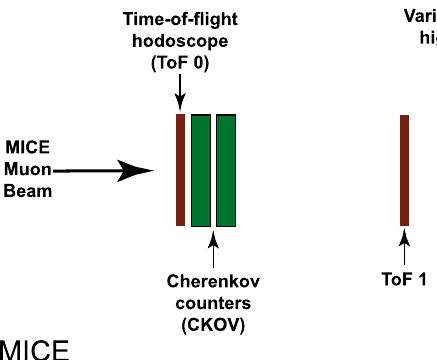
(TOF0, TOF1) [23,24], Cherenkov counters [25], scintillating-fibre trackers [26], KLOE-Light (KL) calorimeter [20,27], and Electron Muon Ranger (EMR) [28,29]) are also represented. The Partial Return Yoke (PRY) is not